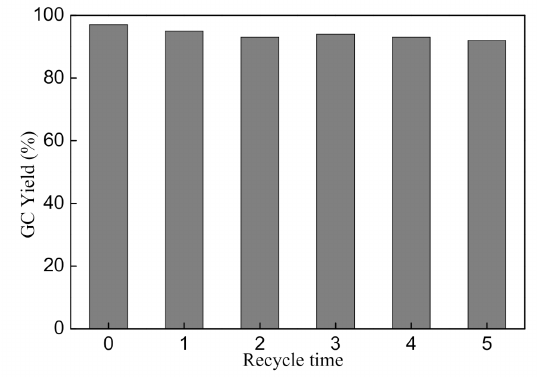
Figure 3. The reusability of the Co-N-Si/AC